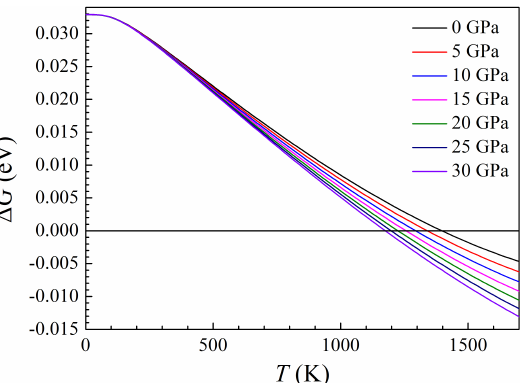
Figure 18. Temperature dependence of the Gibbs free energy difference ( ∆ G ) between the h- and the r-Al 2 Ti LPSs under pressure up to 30 GPa. The positive value shows that the h LPS is more stable than the r